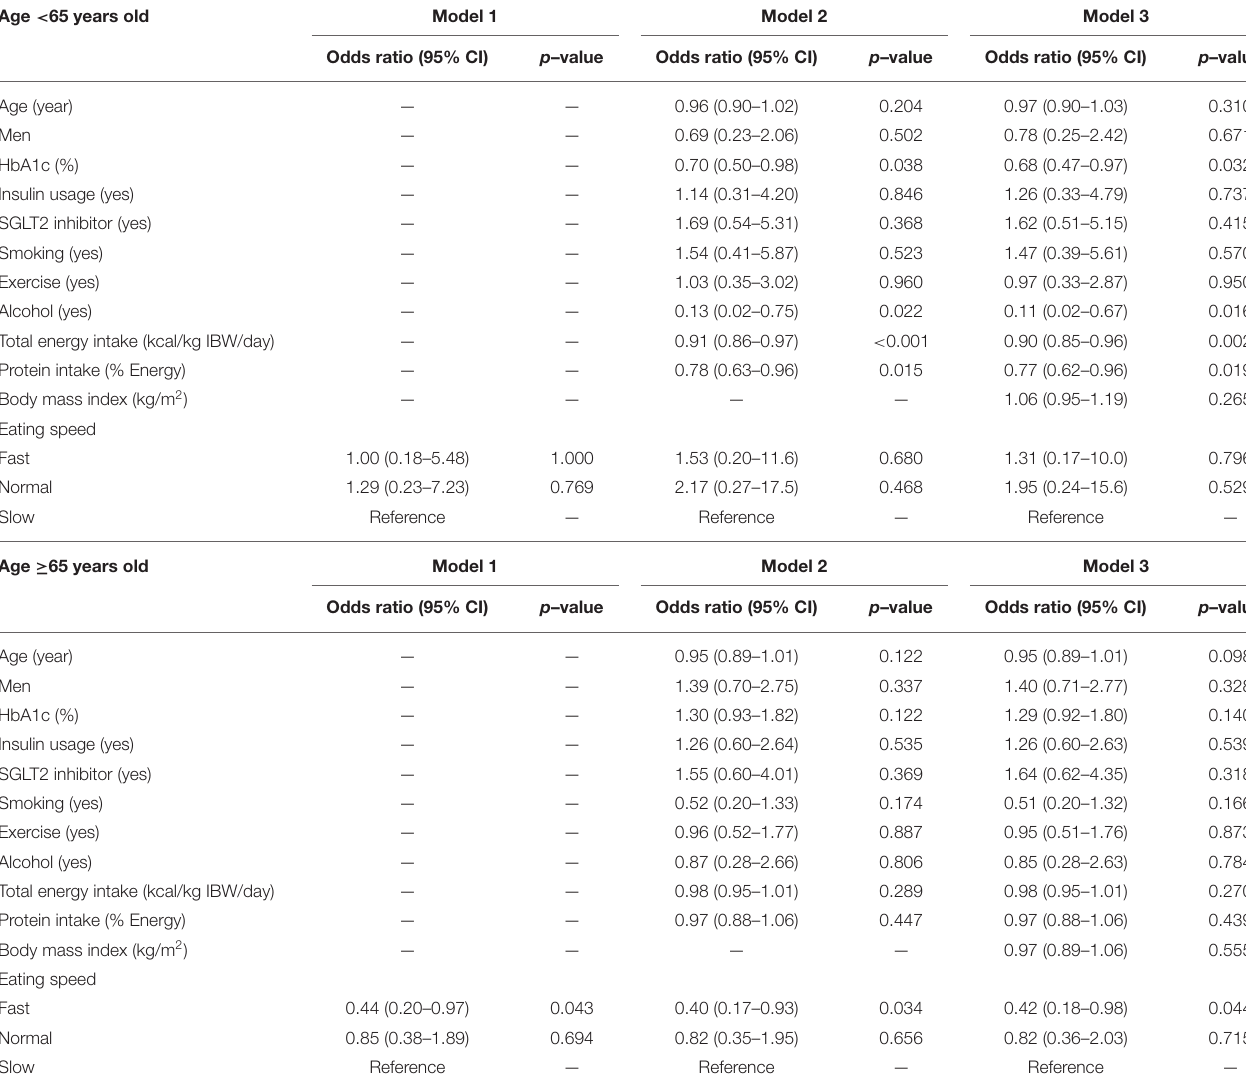
TABLE 3 | Relationship between eating speed and the incident muscle mass